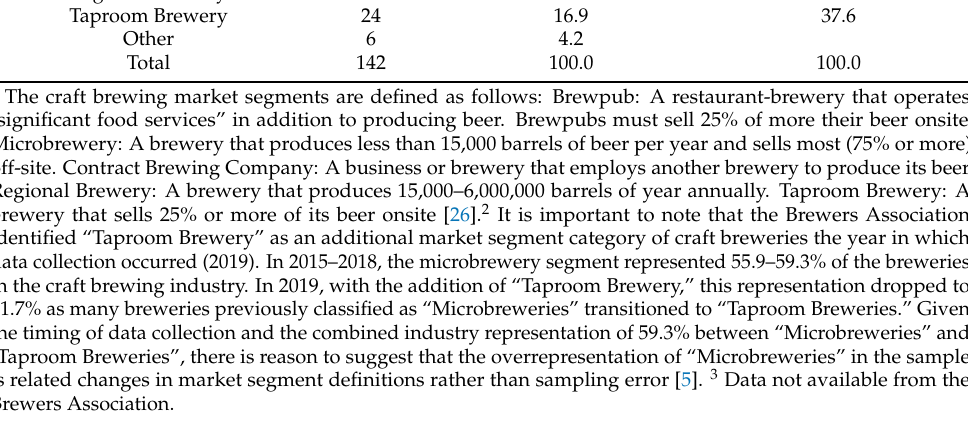
Table 2. Brewery Sample Characteristics: Permit Age, Production Volume, Personnel.